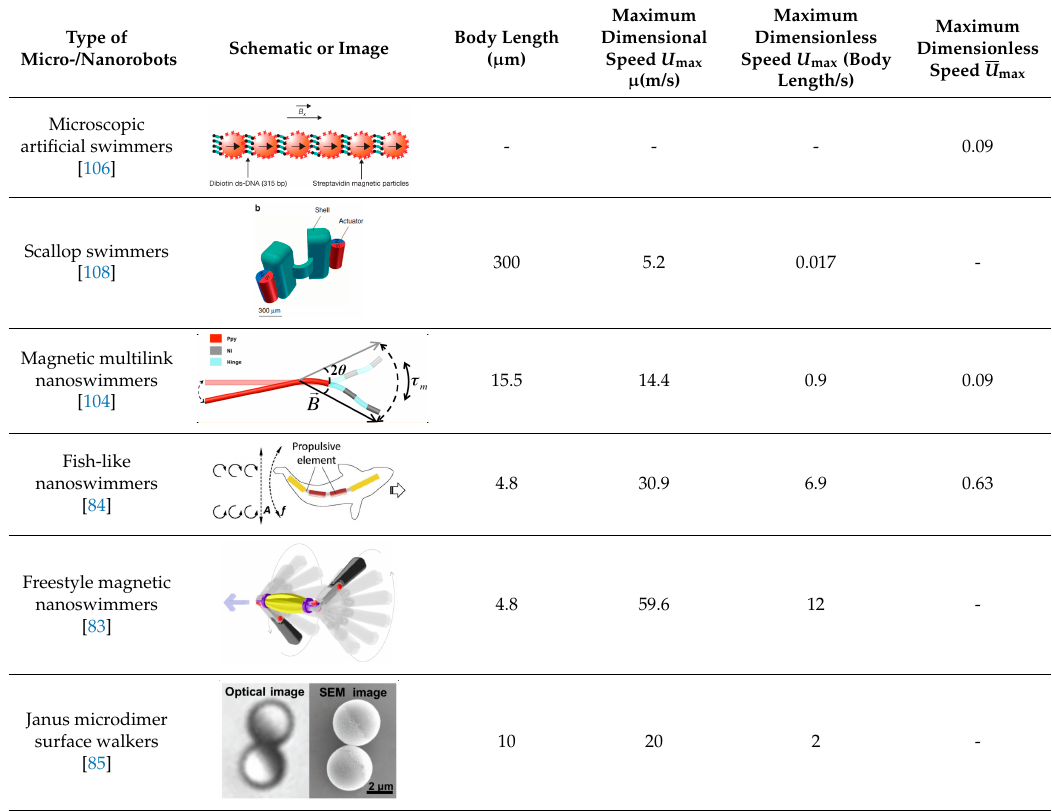
Table 1. Propulsion performance of micro-/nanorobots propelled by oscillating magnetic fields. Type of Micro-/Nanorobots